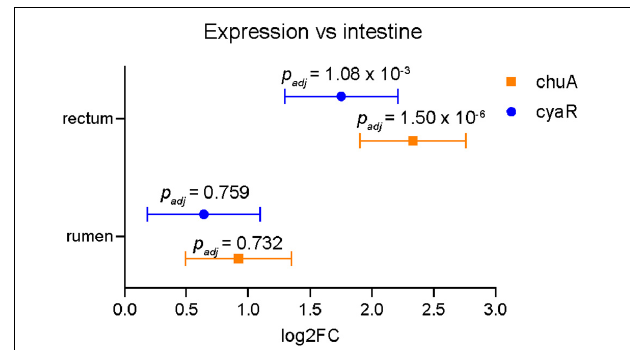
FIGURE 6 | Expression of chuA and CyaR in bovine gastrointestinal niches. Log2FC expression of chuA (orange squares) and CyaR (blue circles) in rectum and rumen compared to intestine. Data from SRA accession SRP136076. Error values are standard errors calculated from DEseq2. Adjusted p -values are calculated from